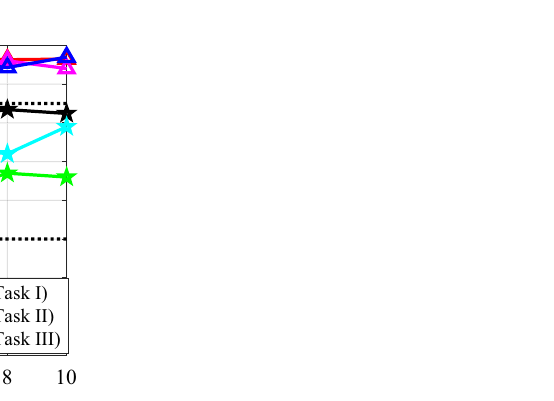
Figure 9. Experimental results between MKJDA and JDA based on signals with the different SNRs.